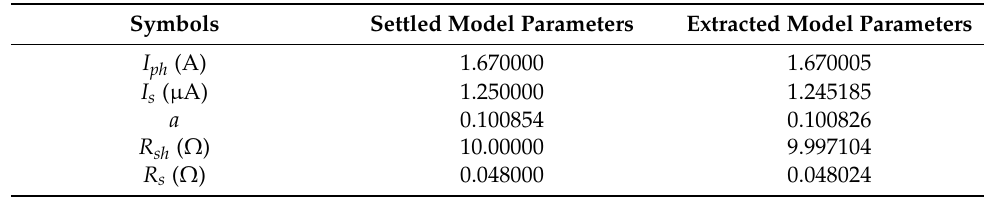
Figure 3. Comparison of calculated P-V characteristics with the settled and estimated parameters shown in Table 1, and the absolute errors between symbols and lines. Table 1. Parameters estimation values of our algorithm.